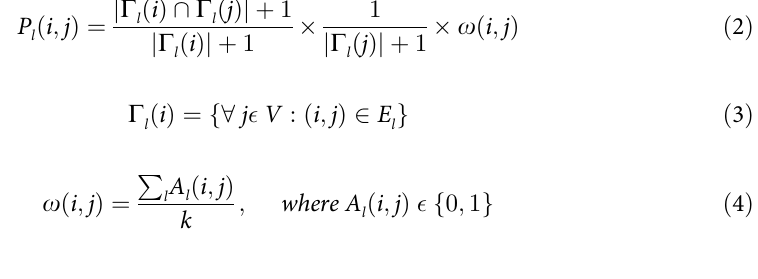
depend on the layer; it is used to smooth probabilities. Also, A of layer l .